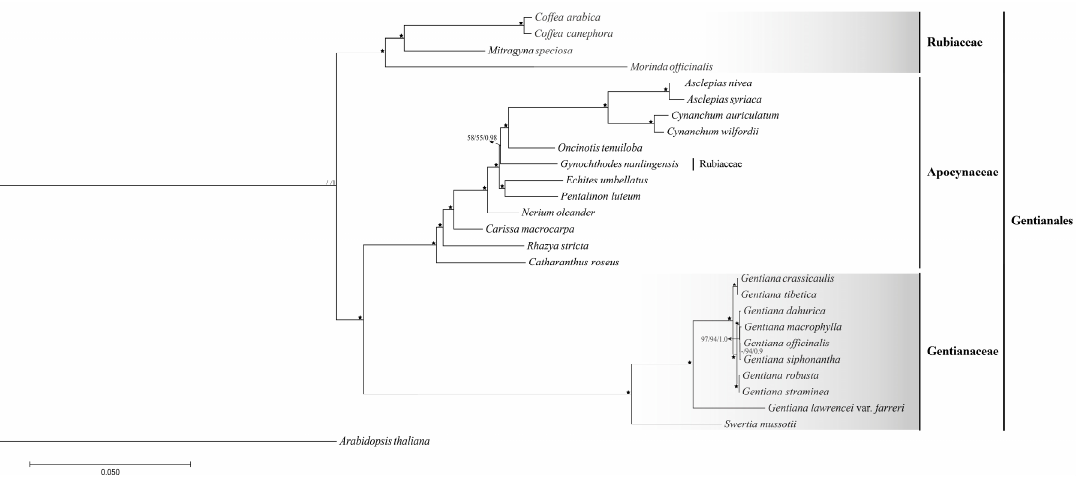
Figure 7. Phylogenetic relationships of species belong to Gentiana sect. Cruciata inferred from MP/ML/BI analysis based on complete chloroplast genome sequences. The numbers associated with each node are bootstrap support and posterior probability values, and the symbol in the phylogenetic tree indicated that the support value of branch is 100/100/1.0.